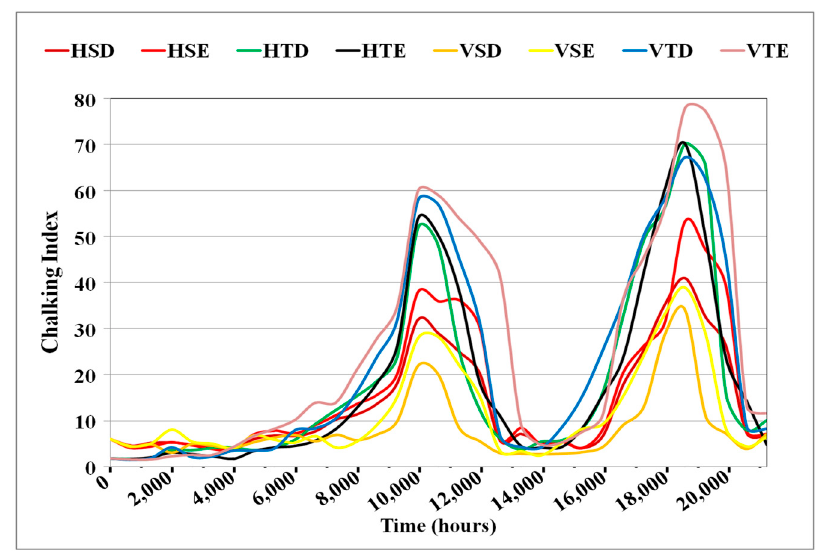
Figure 9. Chalking index.